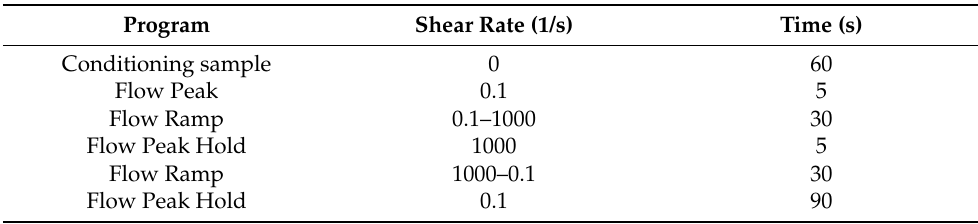
Table 2. The thixotropy behavior